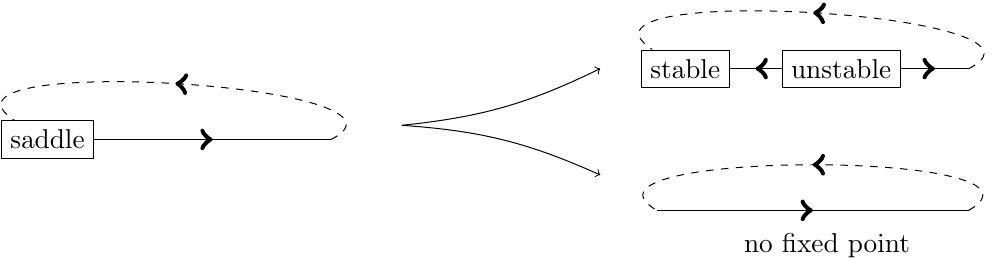
Figure 5 . Two possible instabilities of saddle points associated to marginal operators in non- relativistic RG flow. Limit cycles are associated with infinite spectra of bound